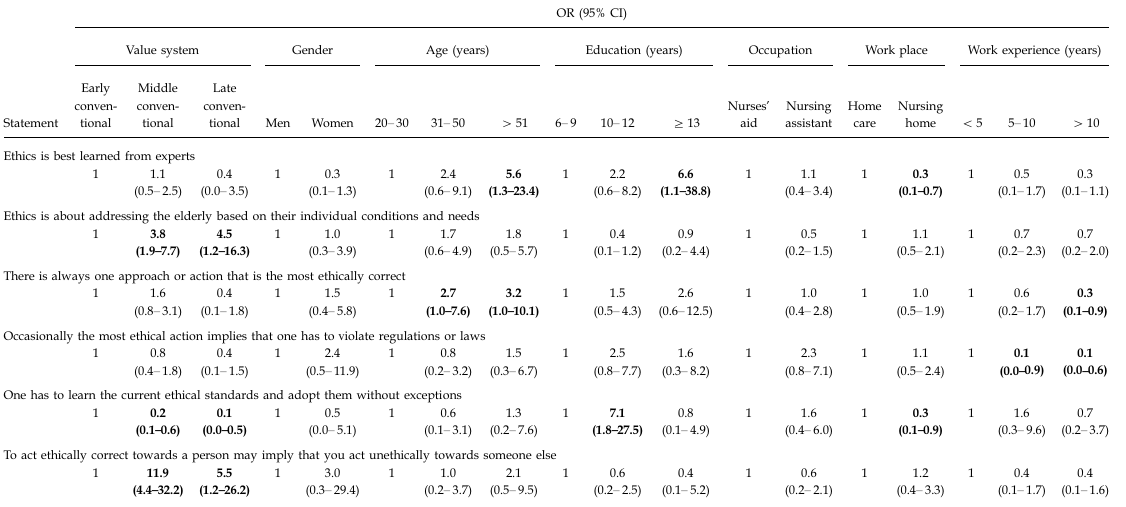
Table 3. Binary logistic regression models for predicting nursing assistants’ and nurses’ aides’ views on care